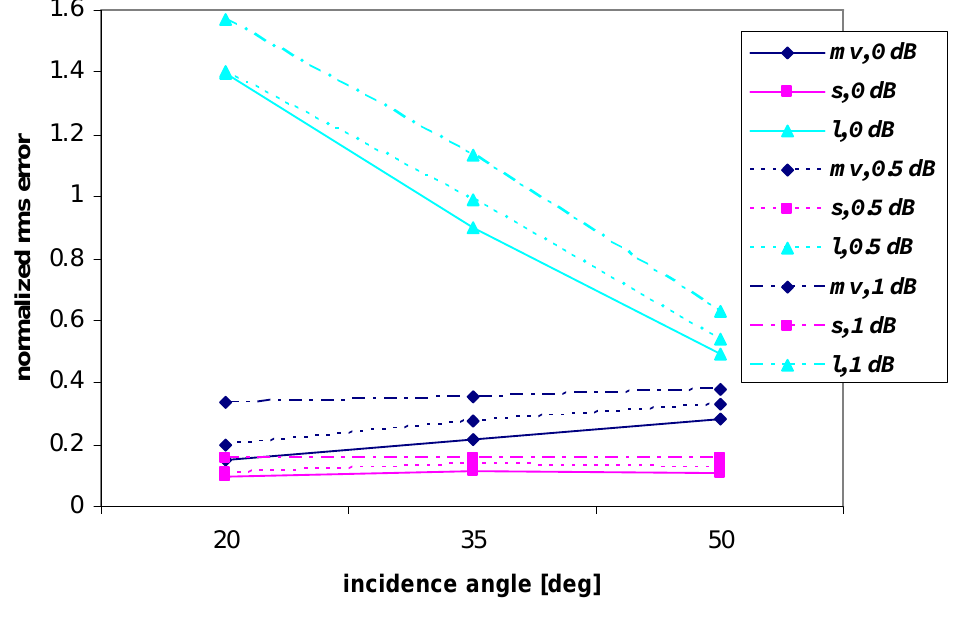
Figure 5 . Accuracy estimation (in terms of normalized rms error) vs. incidence angle for SEM simulation, multifrequency (LCX) and multilook ( n =100) analysis, MAP inversion method. An additive maximum error of 0.5 (dashed lines) and 1 dB (dotted lines) on the terms of the covariance matrix is considered. The case of no additive error is also included (solid